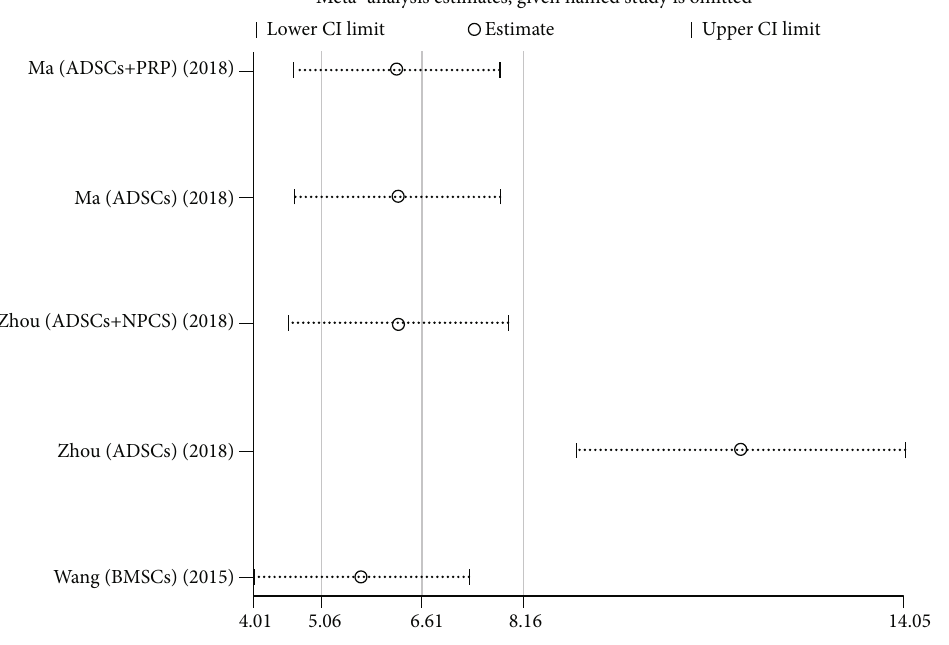
Figure 16: Sensitivity analysis of MRI signal